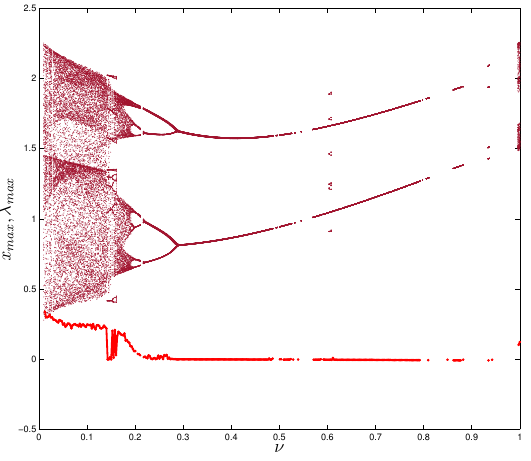
Figure 3. Bifurcation diagram and largest Lyapunov exponent of the fractional-order map (6) when the fractional order ν is varied with b =